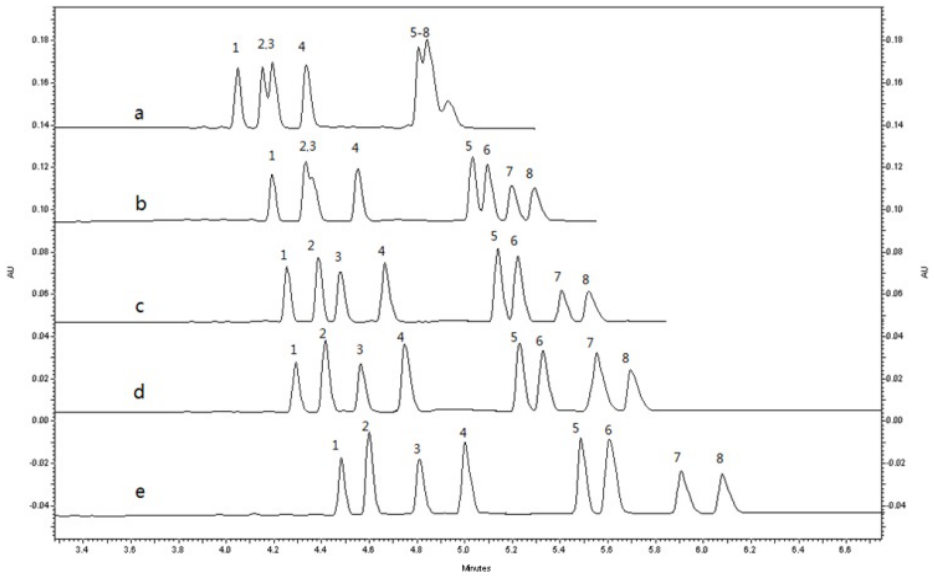
Figure 2. Electropherograms of rac -MRT (200 ng/mL) and its metabolites standard with different chiral selectors (CM- β -CD) concentrations in the BGE: ( a ) 3.0 mg/mL; ( b ) 4.0 mg/mL; ( c ) 4.5 mg/mL; ( d ) 5.0 mg/mL; ( e ) 5.5 mg/mL. Sample solvent: 10% buffer solution; Experimental conditions: running buffer: 25mM phosphate–6.25mM borate (pH3.0); total uncoated capillary length: 40.2 cm × 75 μ M i.d, effective length: 30.2 cm; applied voltage:16 kV (+) → ( − ); column temperature: 20 °C; detection wavelength: 200 nm; electrokinetic injection: 7.5 kV × 10 s. Peaks: (1) ( − )- R -DMR; (2) ( − )- R -MRT; (3) (+)- S -DMR; (4) (+)- S -MRT; (5) ( − )- R- 8-OHM; (6) (+)- S -8-OHM; (7) ( − )- R -N-O-MRT; (8) (+)- S -N-O-MRT.